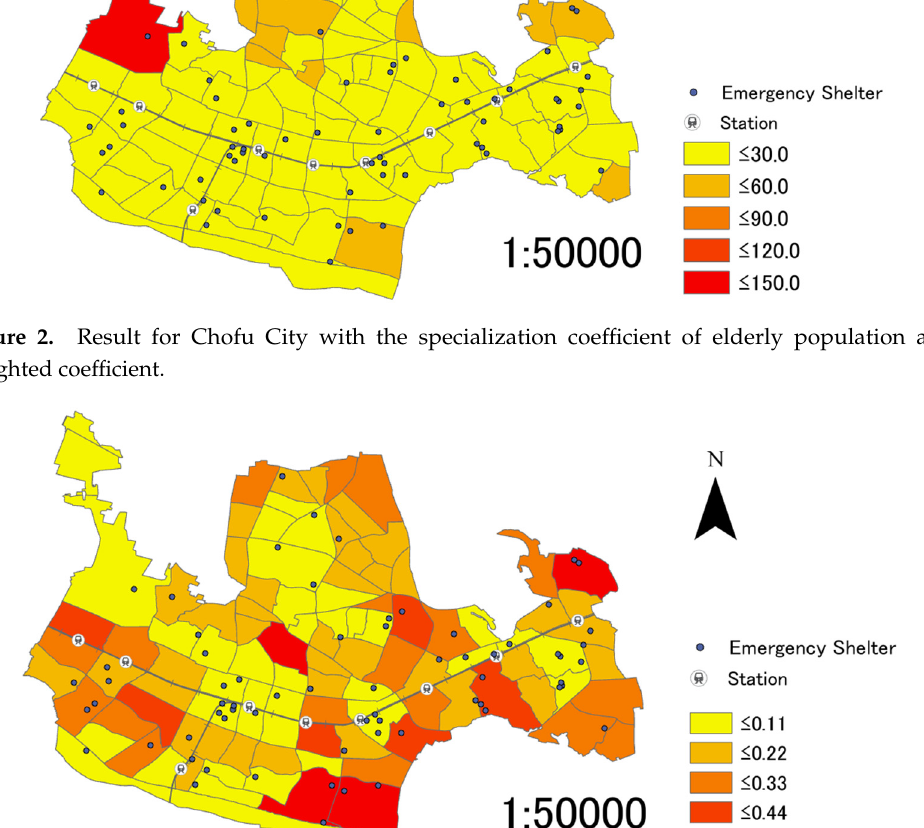
Figure 3. Result for Chofu City with the Ratio of permanent population as a weighted coefficient.